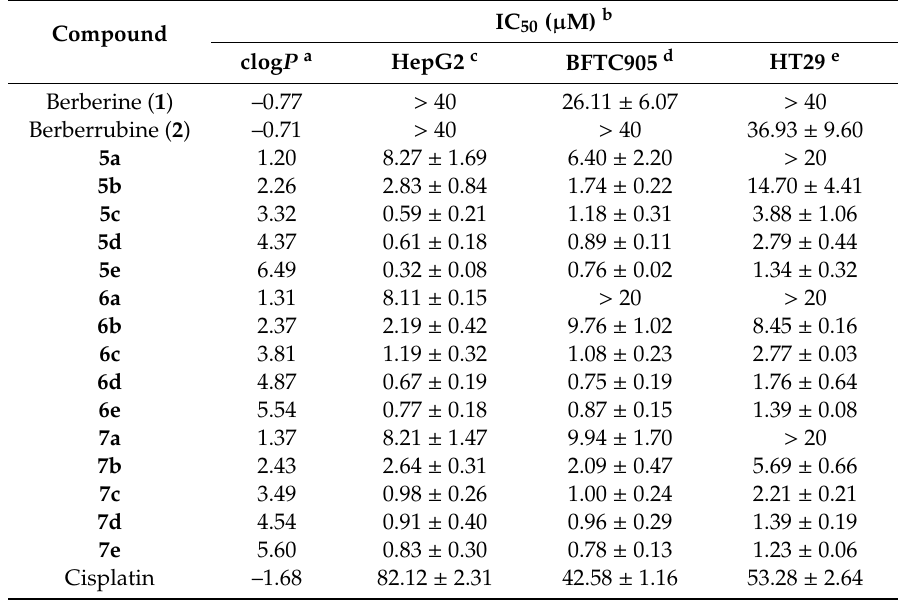
Table 1. Cytotoxicity of berberine and its derivatives against three human cancer cell lines for 24 h. IC 50 ( µ M) b Compound clog P a HepG2